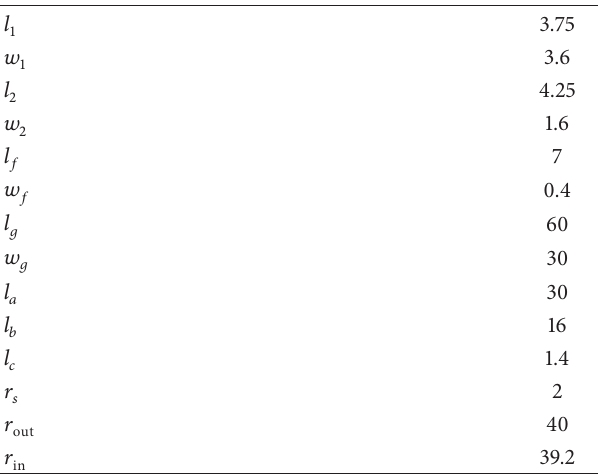
Table 1: Detailed dimensions (unit: